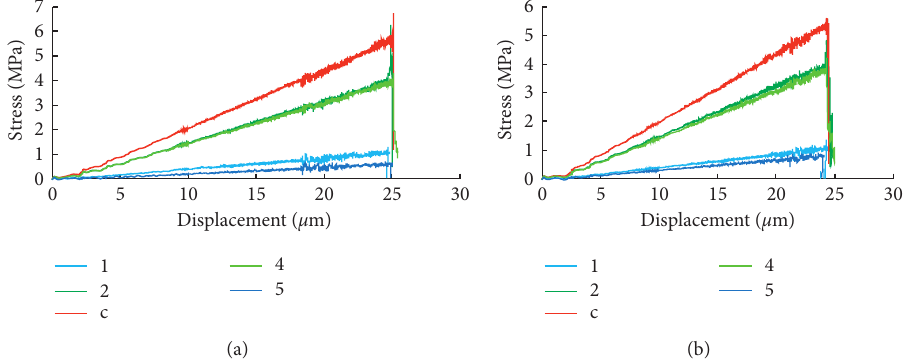
Figure 14: Stress-displacement curves of five monitoring points with uniform parallel bedding and different angles. (a) 0 ° . (b) 45 ° .